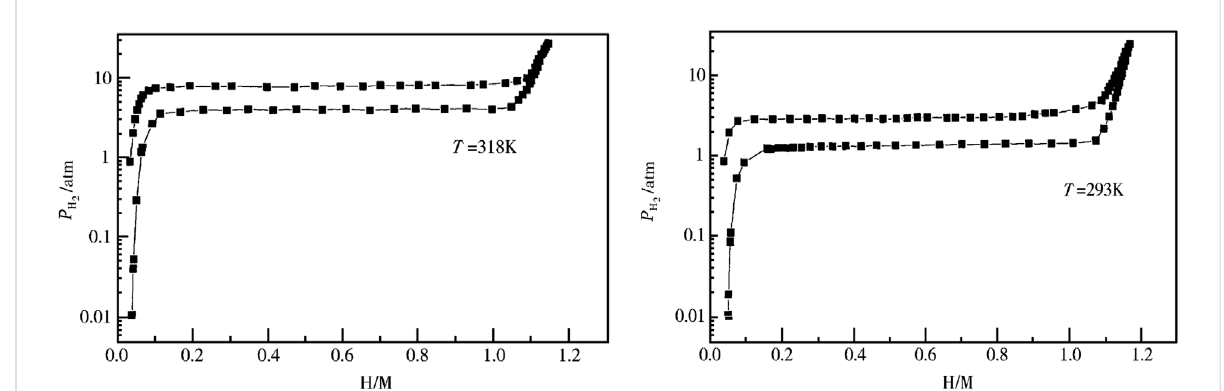
FIGURE 4 Pressure of output of the hydrogen source of a design using a LaNi 5 alloy.